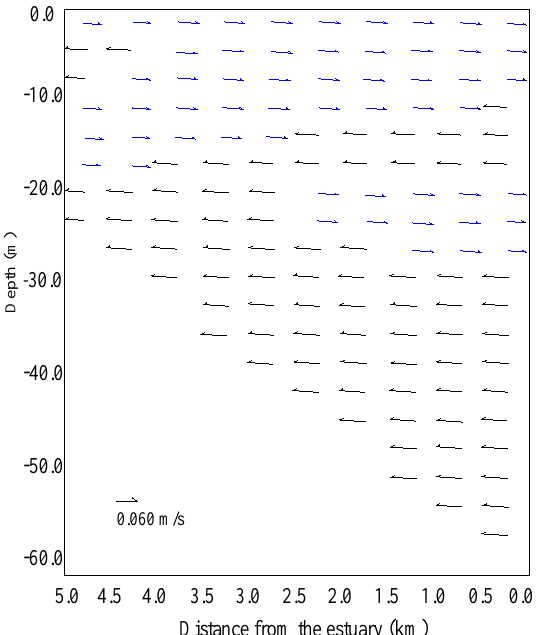
Figure 9. Vertical distribution of flow velocity in the Zhuyi Bay in the dry season. Note: The blue arrows represent the water flows from the Zhuyi Bay into mainstream of the TGR (normal flow velocities), while, the black arrows indicate the reverse flow (reverse flow velocities).